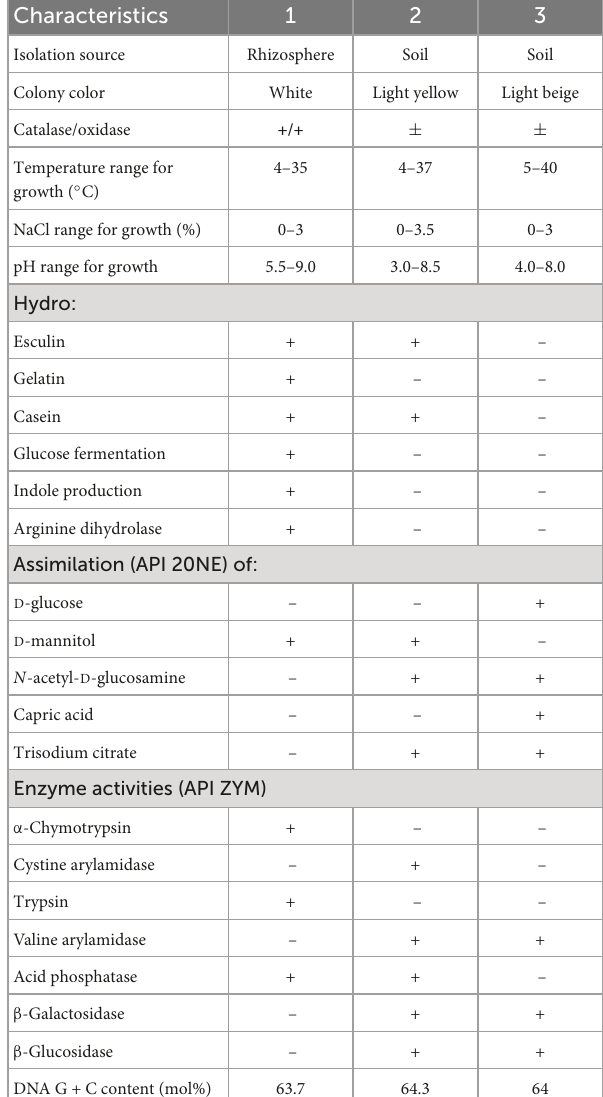
TABLE 1 Differential characteristics of strain RG36 T in comparison with closely related species of Paraburkholderia species.